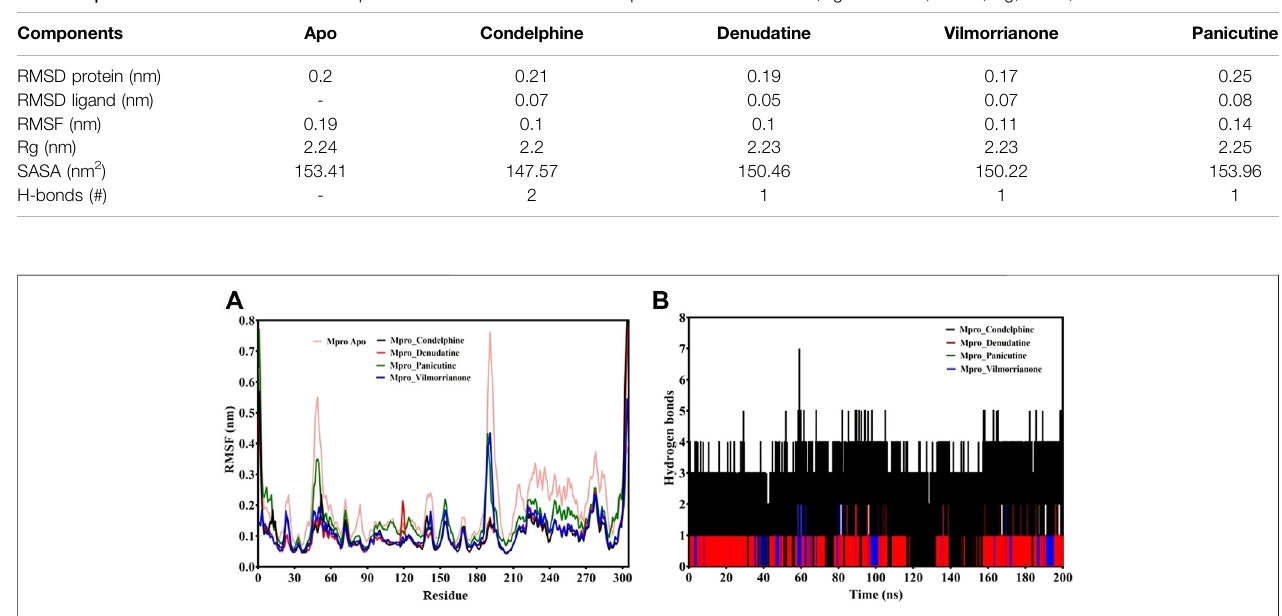
FIGURE 5 | (A) RMSF plot of docking complexes and (B) distribution of hydrogen bonds [control (pink), M pro – condelphine (black), M pro – denudatine (red), M pro – panicutine (green), and M pro – vilmorrianone